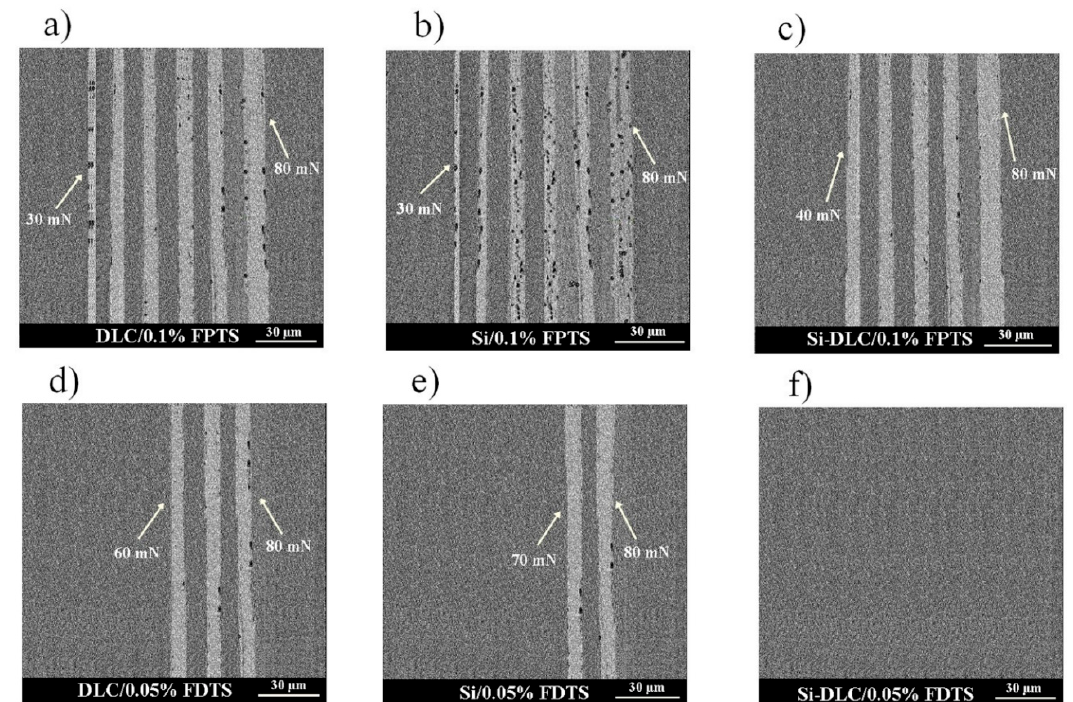
Figure 9. The SEM images of the surface of investigated layer structures after tribological tests: ( a ) DLC/0.1% FPTS, ( b ) Si/0.1% FPTS, ( c ) Si/0.1% FPTS, ( d ) DLC/0.05% FDTS, ( e ) Si/0.05% FDTS, ( f ) Si- ( a ) DLC / 0.1% FPTS, ( b ) Si / 0.1% FPTS, ( c ) Si / 0.1% FPTS, ( d ) DLC / 0.05% FDTS, ( e ) Si / 0.05% FDTS, DLC/0.05% FDTS. ( f ) Si-DLC / 0.05%